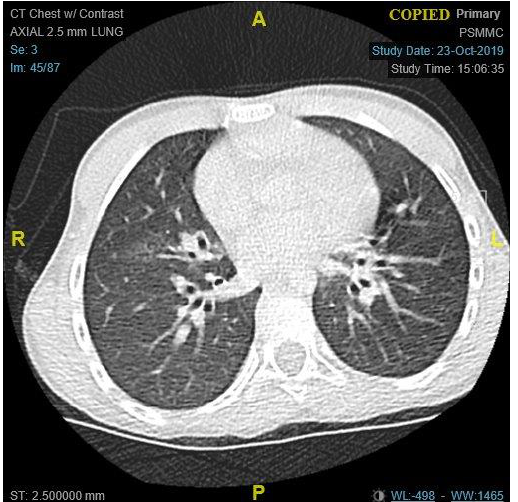
Figure 2. A plain chest X-ray, an anteroposterior film, showing a radioopaque opacity infiltrate seen over the right and left lower zone with mild hyperinflation. (L = Left).